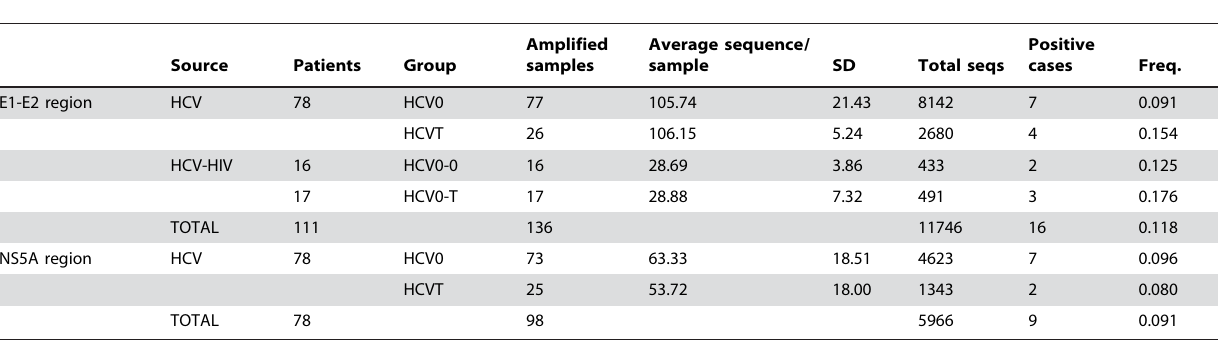
Table 1. Summary of patients, sequence data sets and recombination analysis